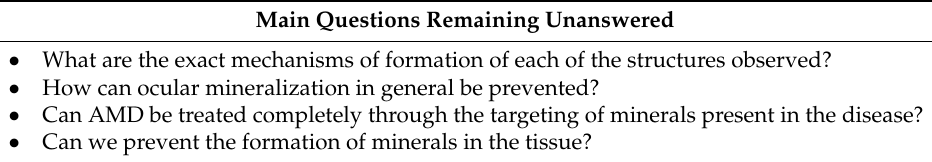
Table 5. List of main questions that remain unanswered in relation to ocular calcification. Main Questions Remaining Unanswered